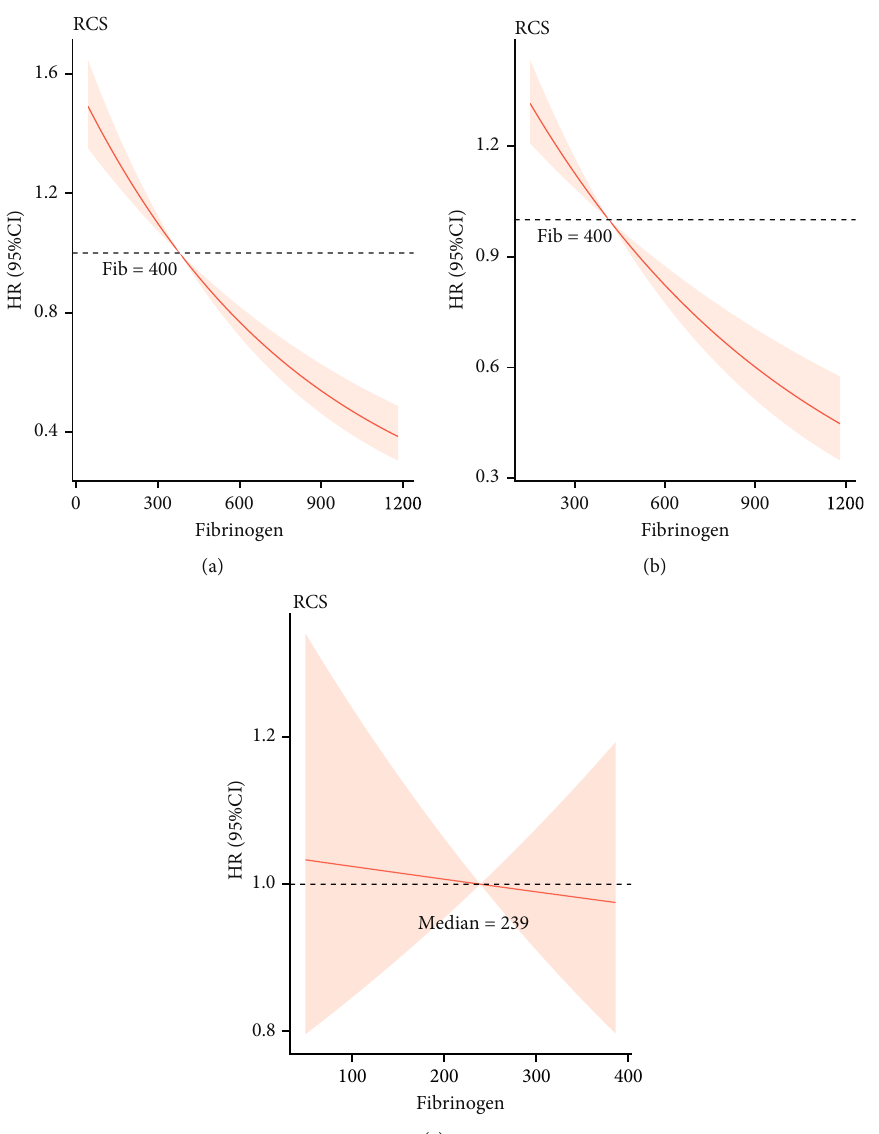
Figure 4: Restricted cubic spline of (a) Cox regression based on all included patients before propensity score matching. (b) Cox regression based on patients with elevated fi brinogen and normal fi brinogen after PSM. (c) Cox regression based on patients with decreased and normal fi brinogen after